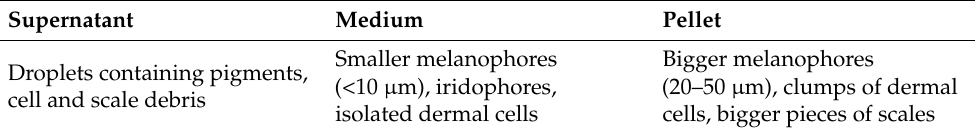
Table 2. Different fractions after gradient centrifugation in Histopaque-1077.